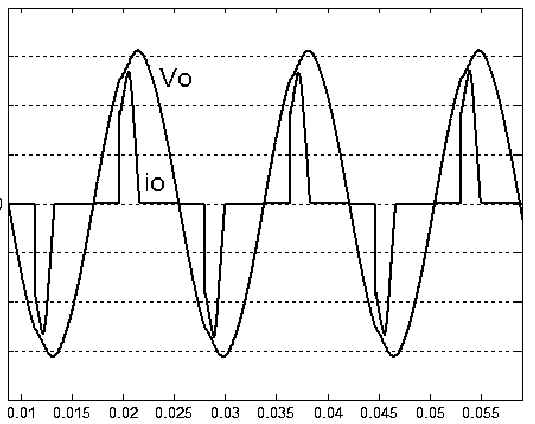
Figure 6. Output voltage and current for simulation of the proposed solution under rectifier ‐ type load (vertical: 50 V/div and 25 A/div).